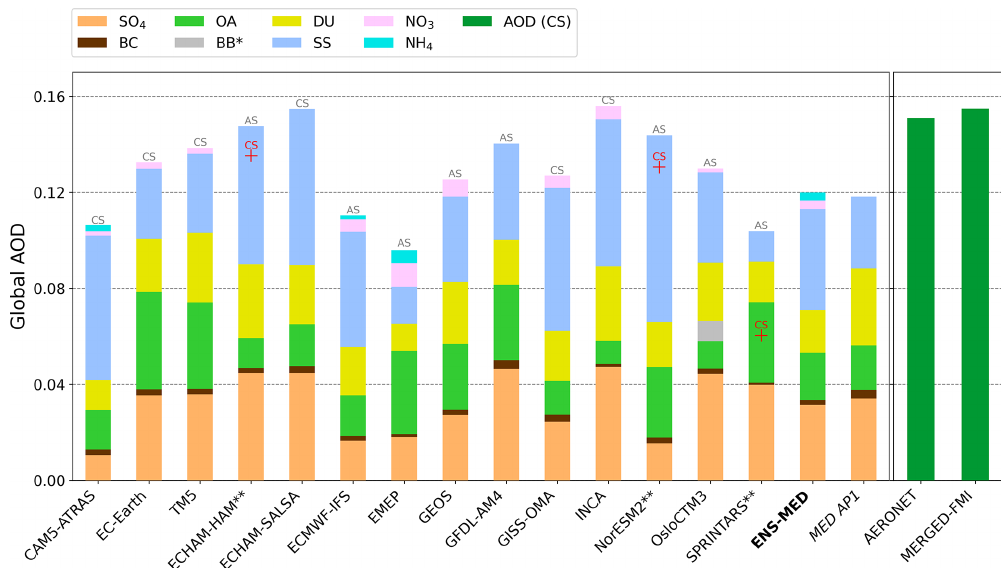
Figure 3. Species contributions to total AOD for each model (annual global average). The type of total AOD (AS or CS) is indicated at the top of each bar. BB* denotes biomass burning OD in OsloCTM3. Models with ** in their name submitted speciated ODs for AS conditions and total AOD for both CS and AS. The corresponding CS AODs are indicated in red with a + symbol. Also shown are estimates of total global CS AOD from AERONET and MERGED-FMI (see main text for details), similar to Fig. 3 in Kinne et al.